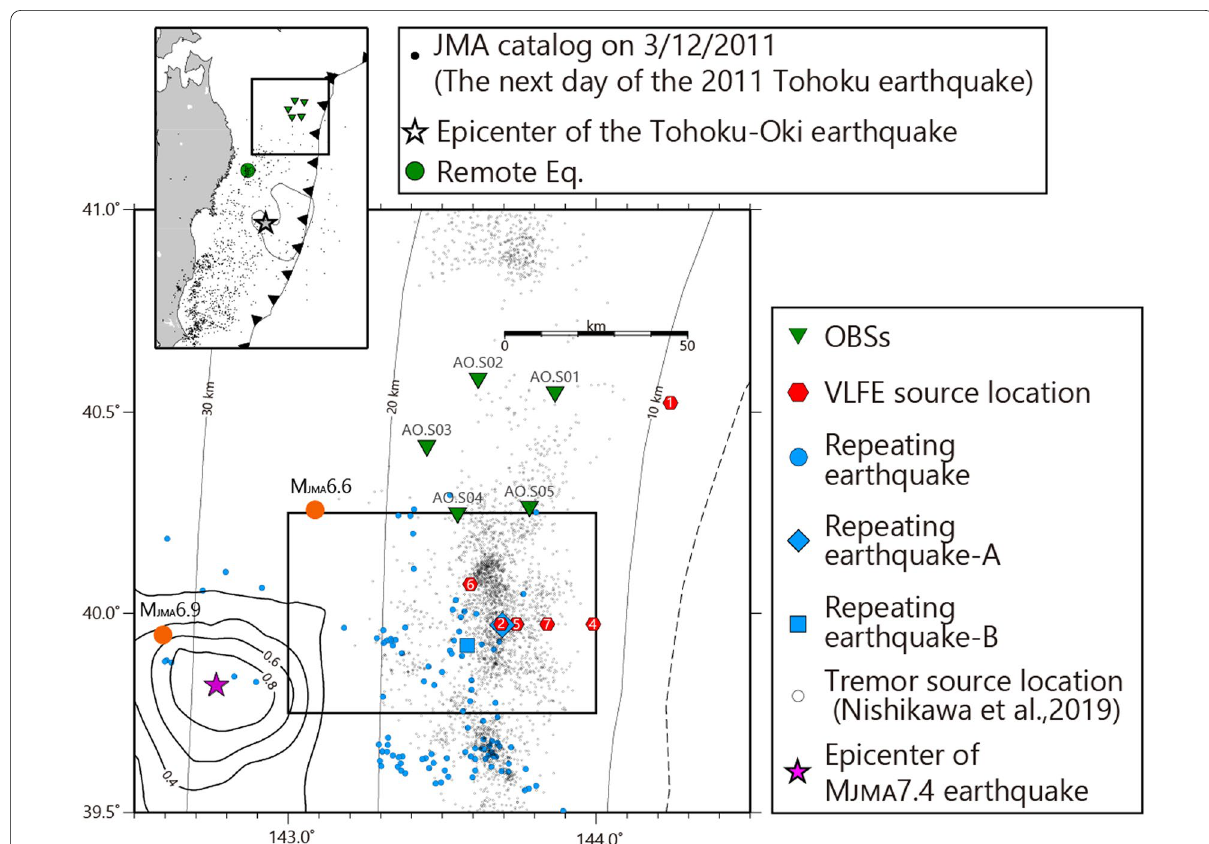
Fig. 1 Locations of ocean-bottom seismometers (OBSs) and known very low-frequency earthquakes (VLFEs). The epicenter of VLFE #3 is the same as VLFE #5. Reverse triangles and hexagons represent OBSs and VLFEs, respectively. Blue circles represent repeating earthquakes that occurred between April 10 and October 25, 2011. Diamond represents a repeating earthquake-A (M3.9) whose seismograms are compared to those of the tremors. Square represents a repeating earthquake-B (M2.7) with the closest hypocenter to tremors. The depth contours of the plate boundary (Nakajima and Hasegawa 2006) are shown by black lines. Black circles indicate the epicenters of tremors (Nishikawa et al. 2019), while dashed line indicates the trench axis of the Japan Trench. The black dots in the inset map on the upper left are Japan Meteorological Agency epicenters of regular earthquakes on March 12, 2011, defining the aftershock area of the 2011 Tohoku-Oki earthquake, whose epicenter is shown by a